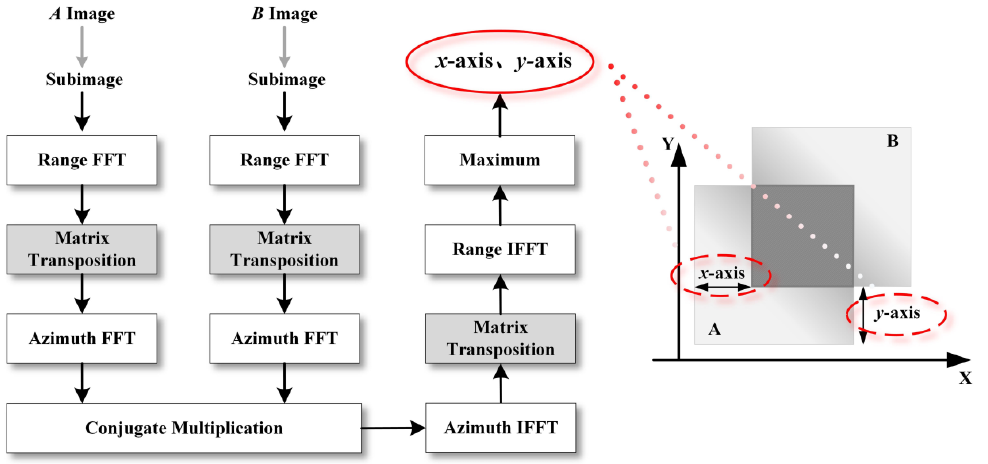
Figure 1. FPGA calculation flow of the algorithm. “FFT” refers to ”Fast Fourier Transform”. ”IFFT” represents “Inverse Fast Fourier